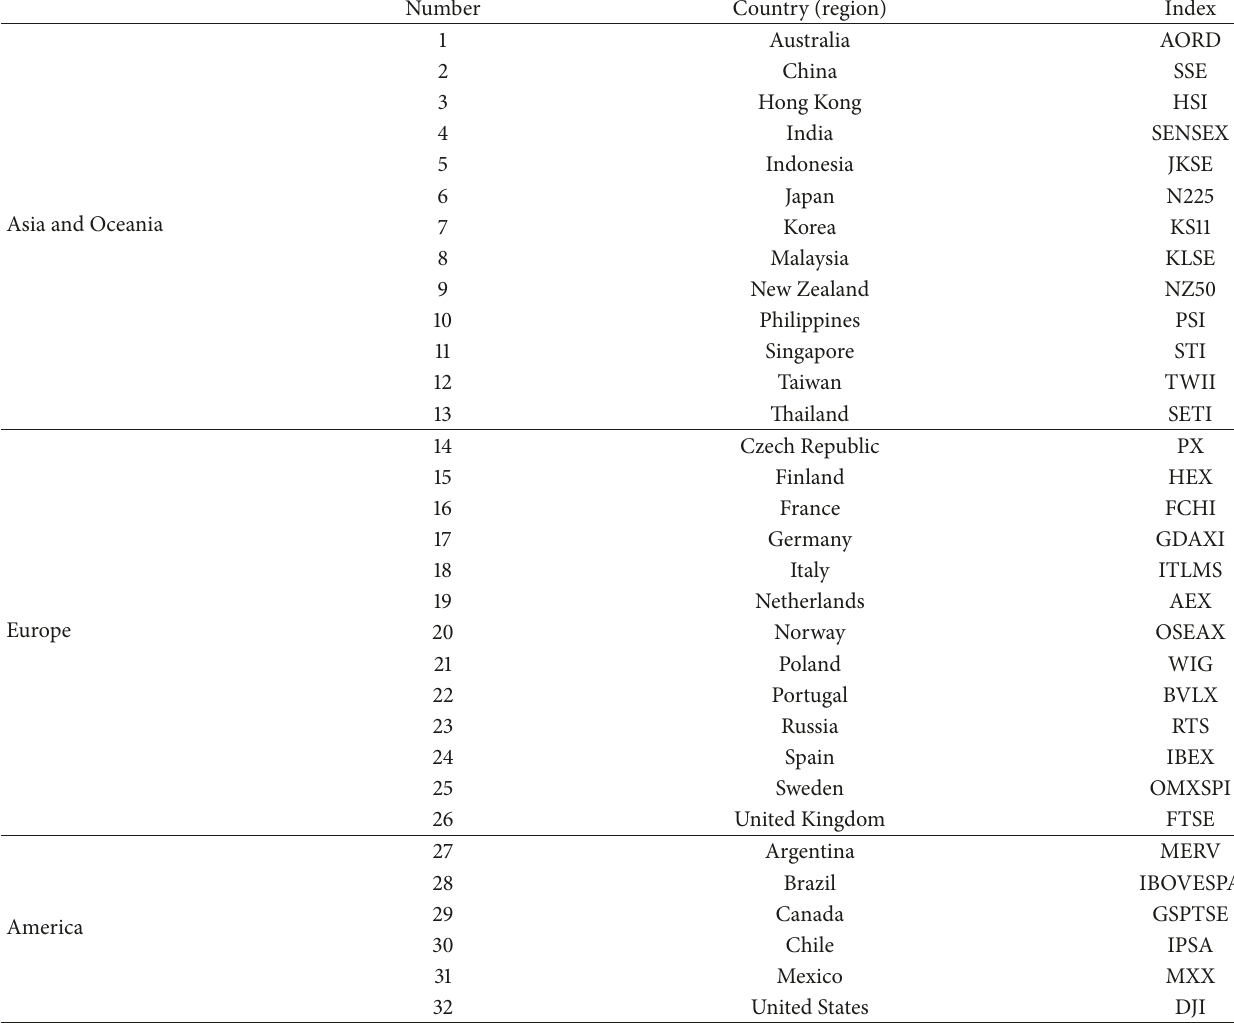
Table 1: Details of the 32 countries (or regions) and their stock